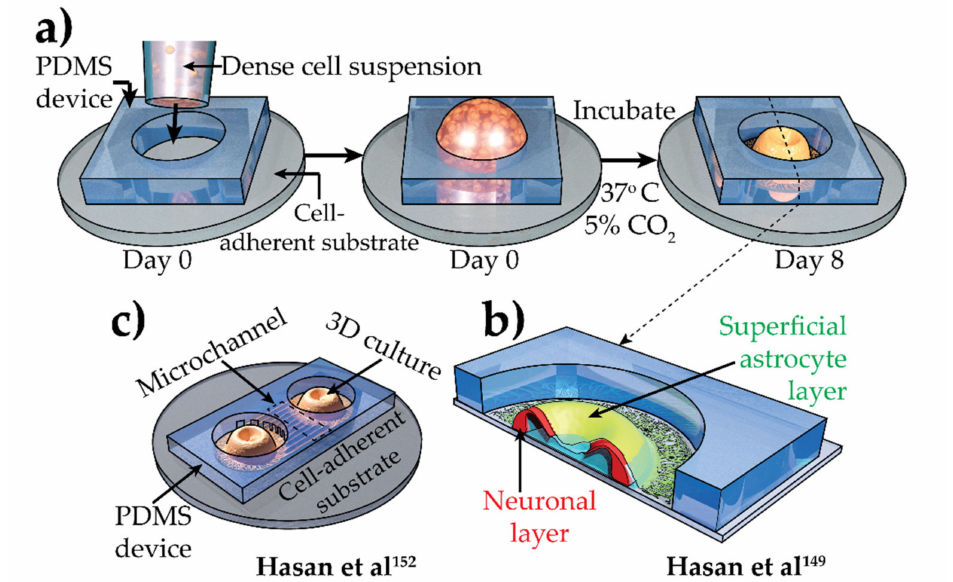
Figure 4. Simplified process to create scaffold-free, confined, adhered 3D culture [149]. ( a , b ) Cross-section along dashed line shows juxtaposed neuronal (red) and astrocytic (green) layer. ( c ) Microchannel- connected 3D culture [152]. CO 2 , carbon dioxide; PDMS, polydimethylsiloxane; 3D,